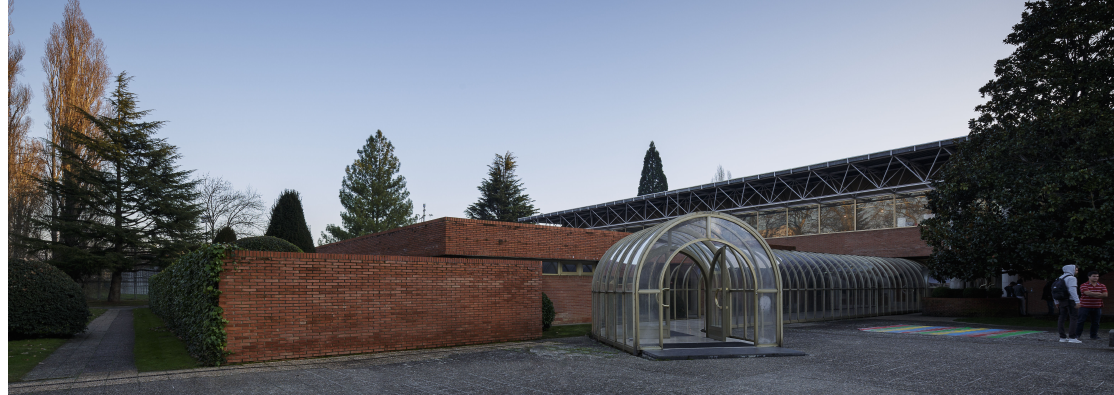
Figure 3. Office building, School of Architecture (University of